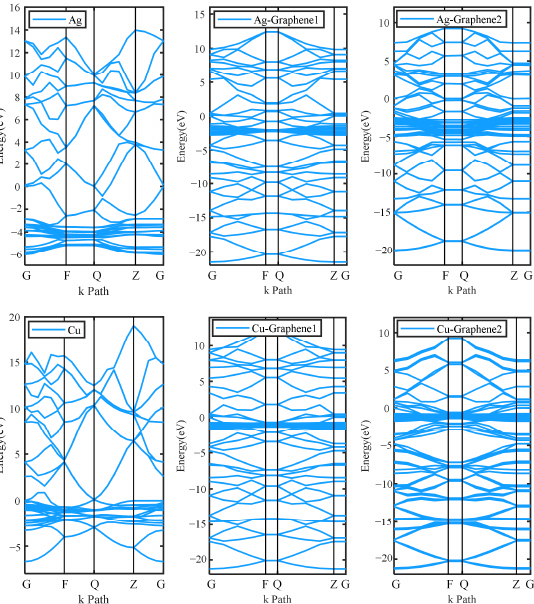
Figure 4. Energy band structure of different electrode plates.